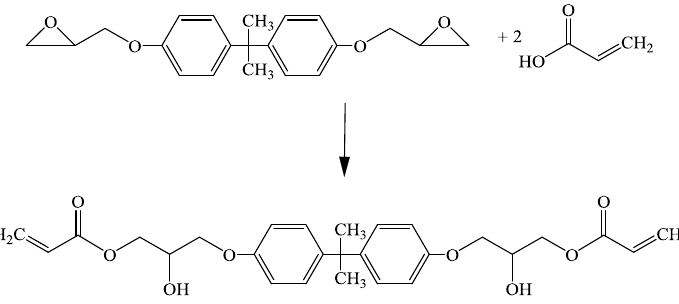
Figure 7. Neutralization reaction scheme of acrylic acid with diglycidyl ether bisphenol A [29]. Table 4. Acid value and viscosity of oligolactide acrylates.